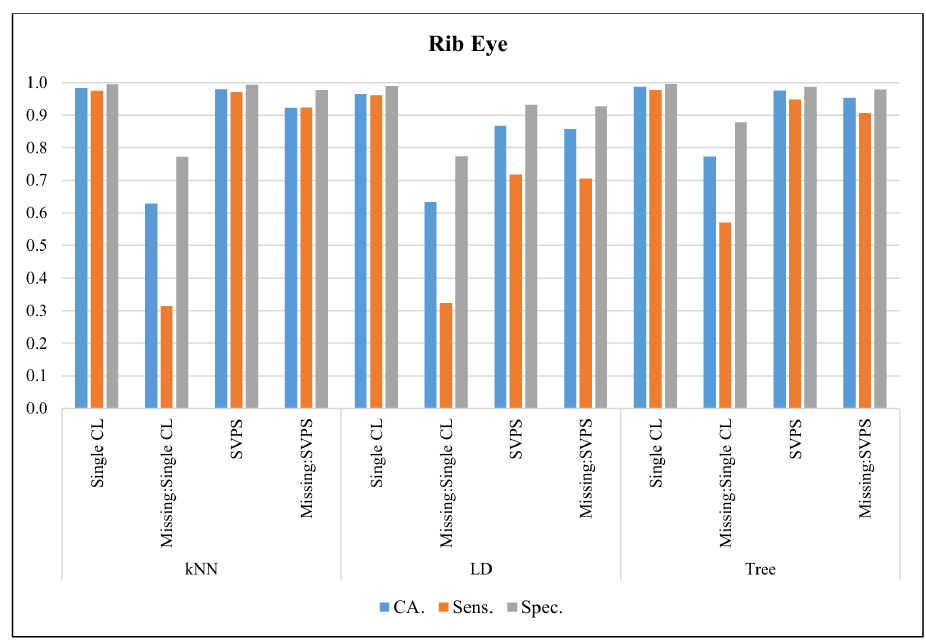
Figure 13. Classification results for Rib Eye